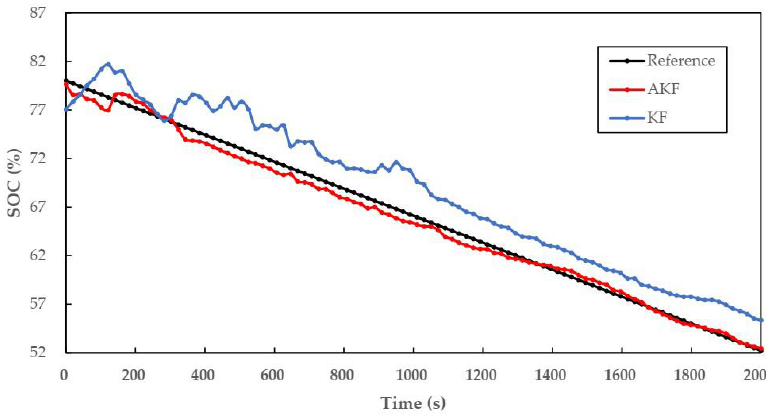
Appl. Sci. 2019 , 9 , x FOR PEER REVIEW Figure 3. The estimate of SOC using methods of AH, AKF, and KF. Figure 3. The estimate of SOC using methods of AH, AKF, and KF.